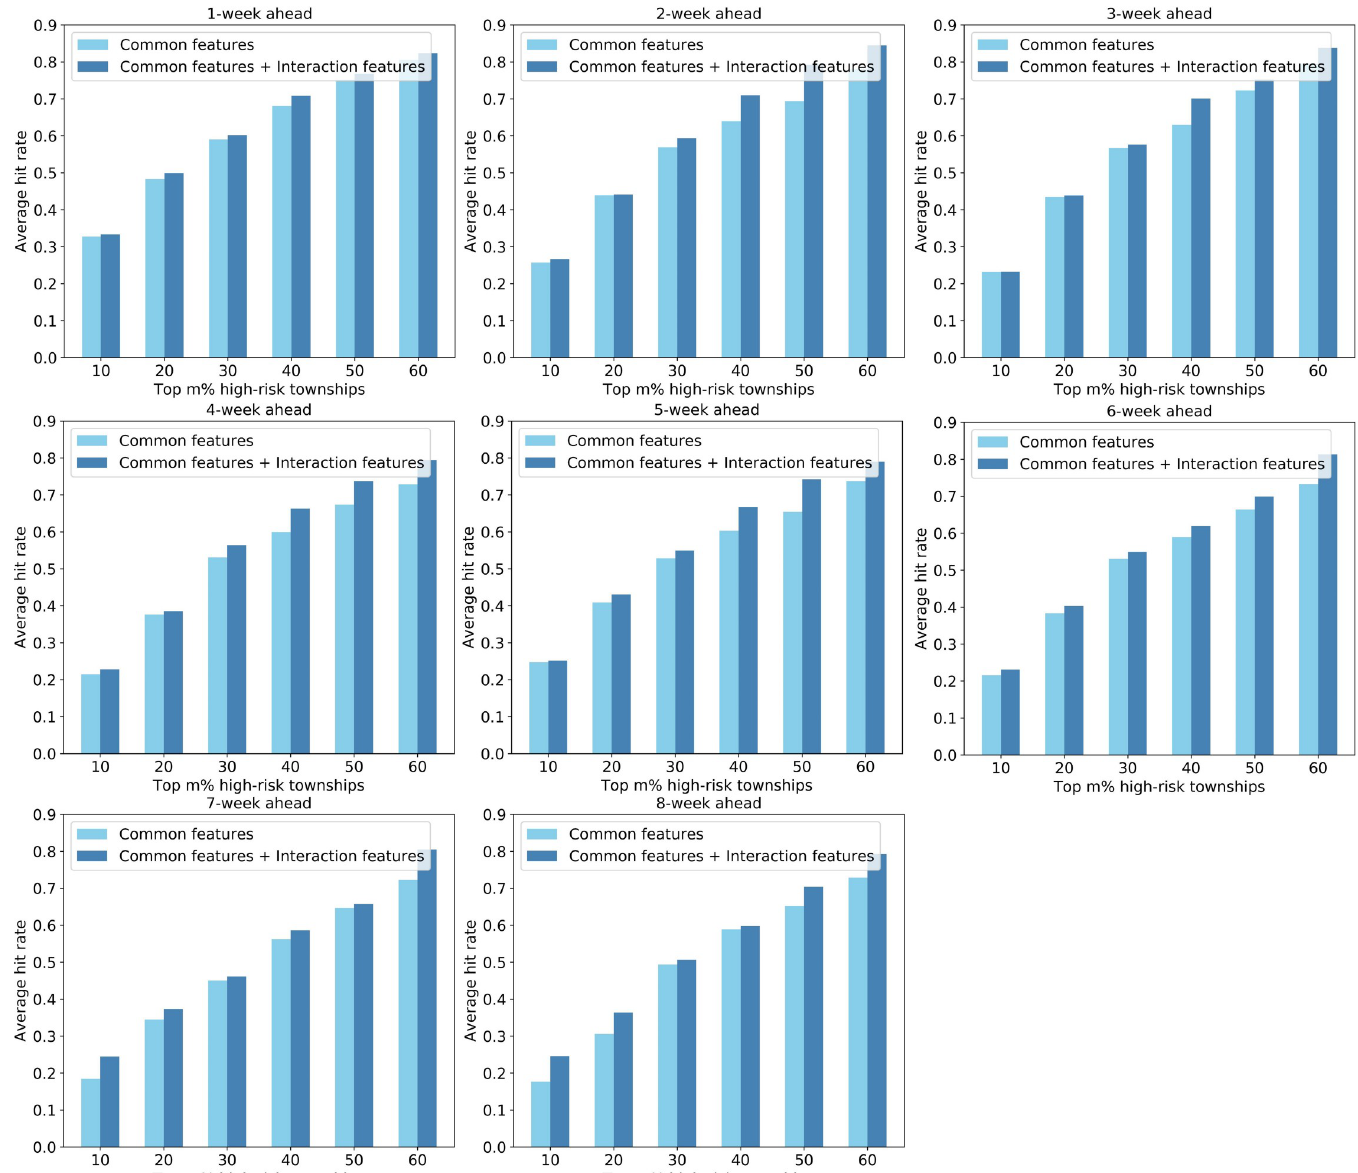
Fig 13. Performance comparison of the ANN-based models with and without interaction features based on the hit rate